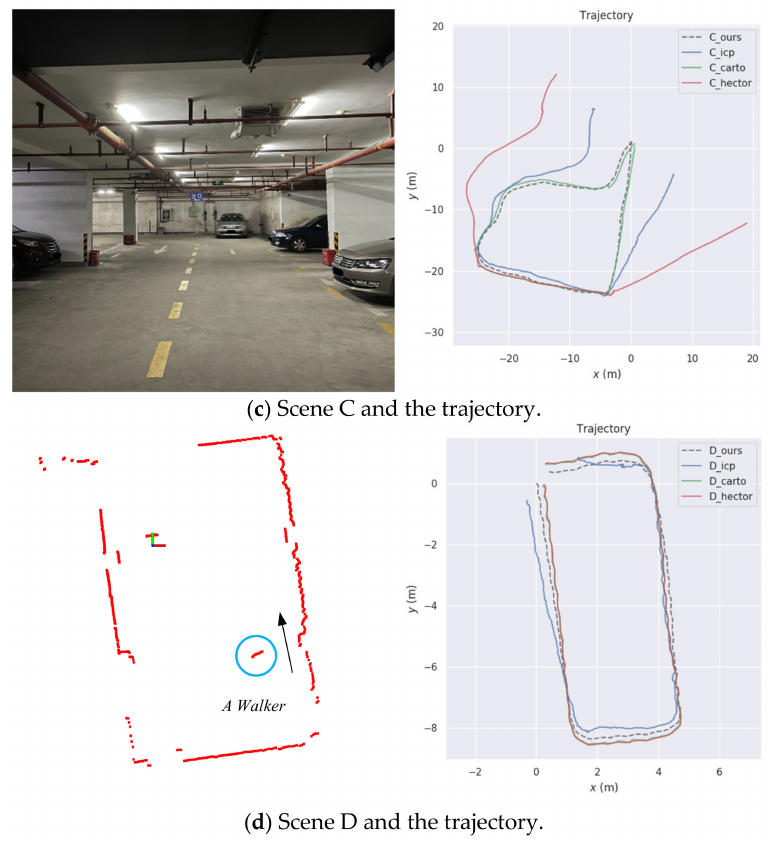
Figure 6. ( a – c ) Static scenes from the underground garage. ( d ) The dynamic scene from the lab.